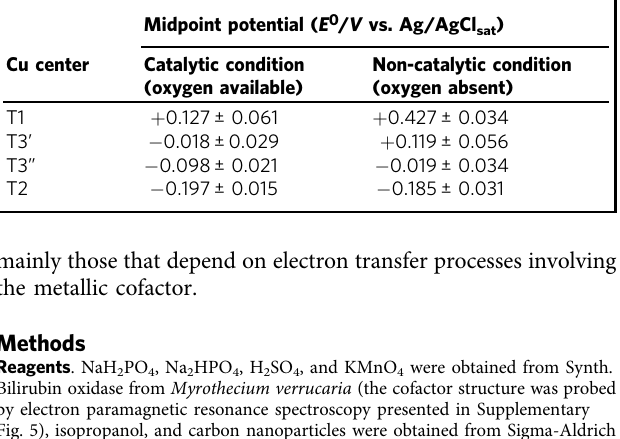
Table 1 Midpoint potential of the Cu centers of Mv BOD for their consecutive 1-electron